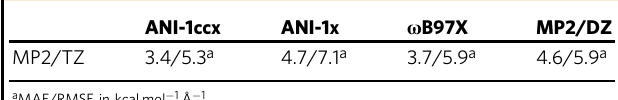
Table 2 Accuracy for calculating atomic forces on the GDB- 10to13